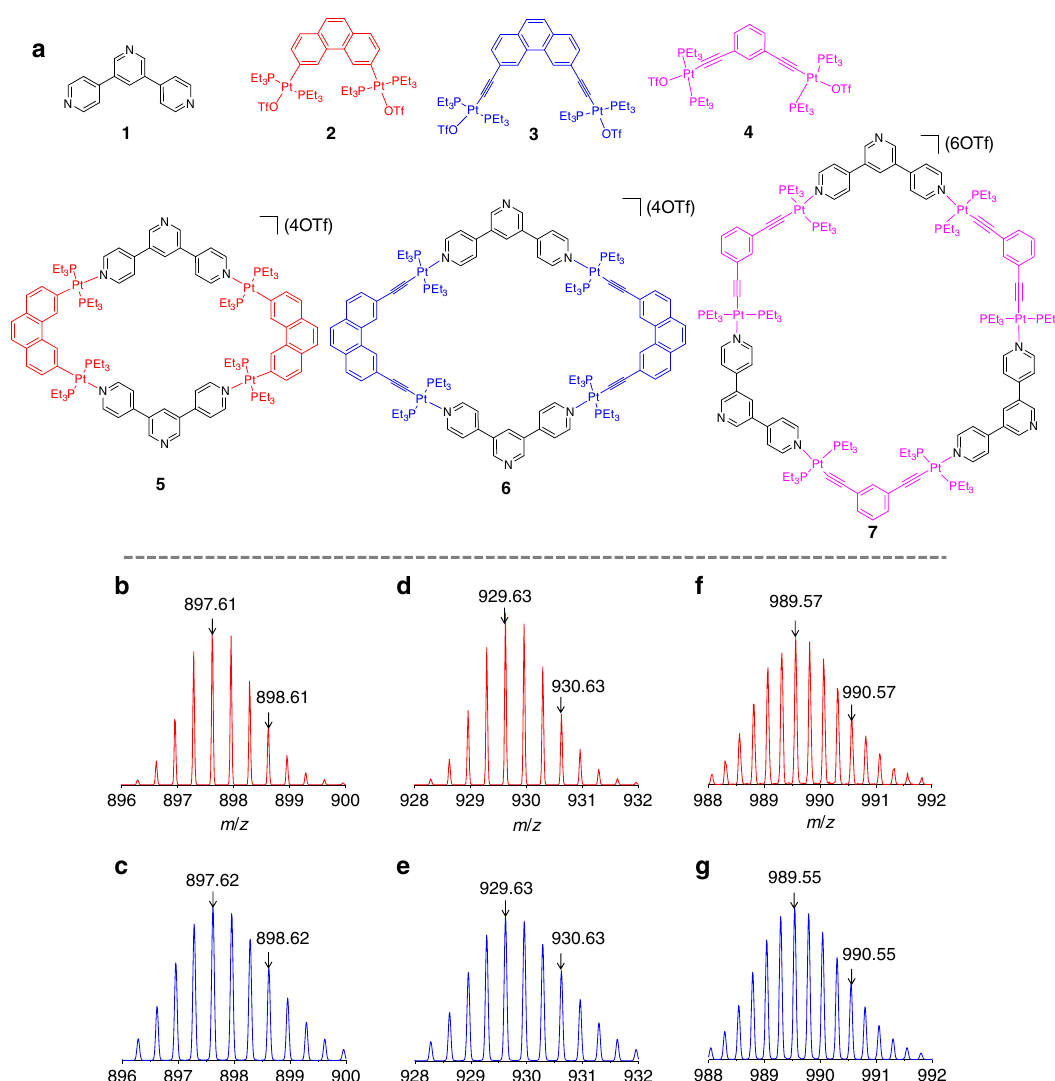
Fig. 1 Compounds studied in this work and characterizations. a Molecular structures of 1 – 7 . b , d , f ESI-TOF-MS experimental data and c , e , g